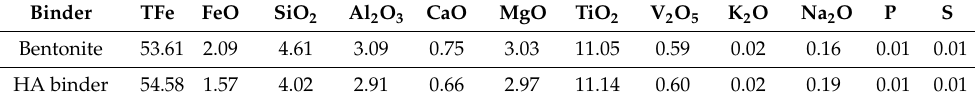
Table 4. Chemical composition of the fired VTM pellets obtained using different binders/wt%. Binder TFe FeO SiO 2 Al 2 O 3 CaO MgO Bentonite